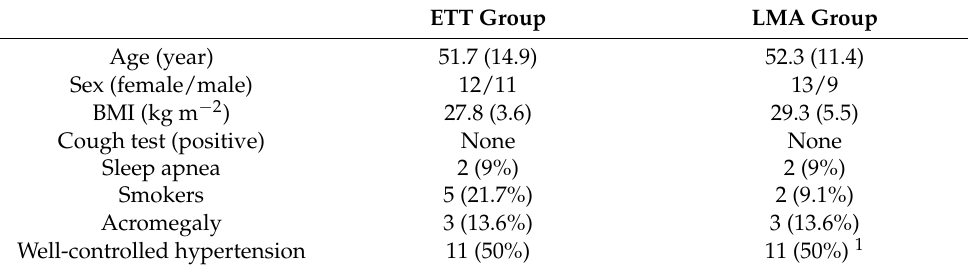
Table 1. Patient characteristics.